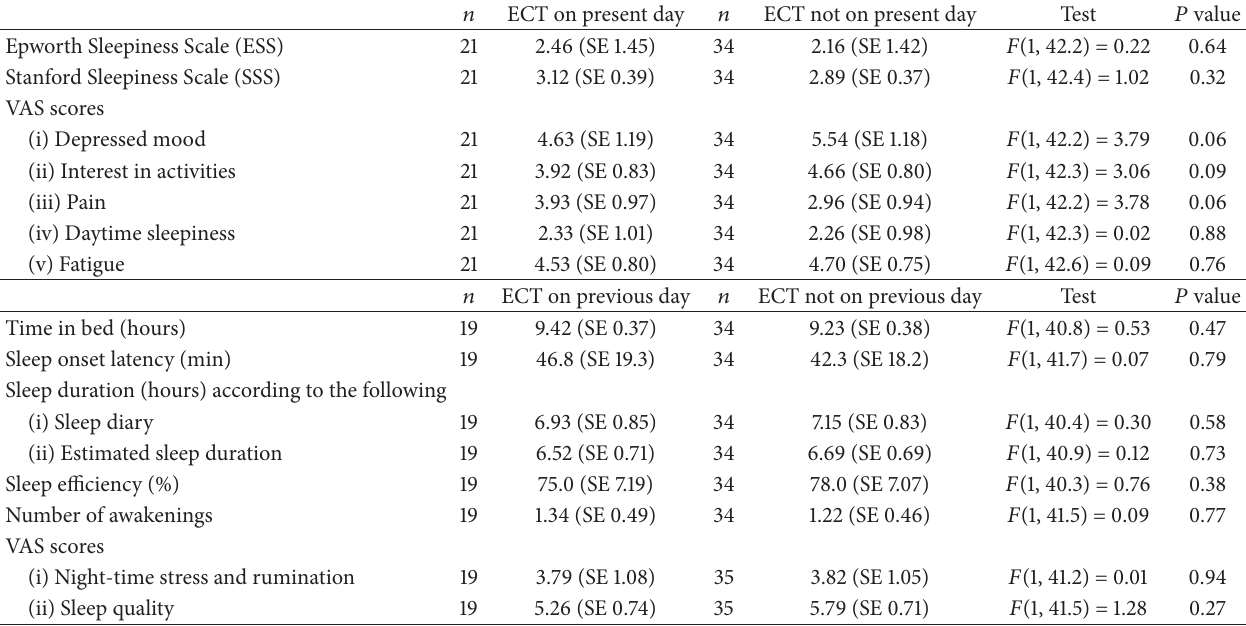
Table 2: Effects of electroconvulsive therapy on subjective parameters in 12 patients with a depressive episode. 𝑛 ECT on present day 𝑛 ECT not on present day Test